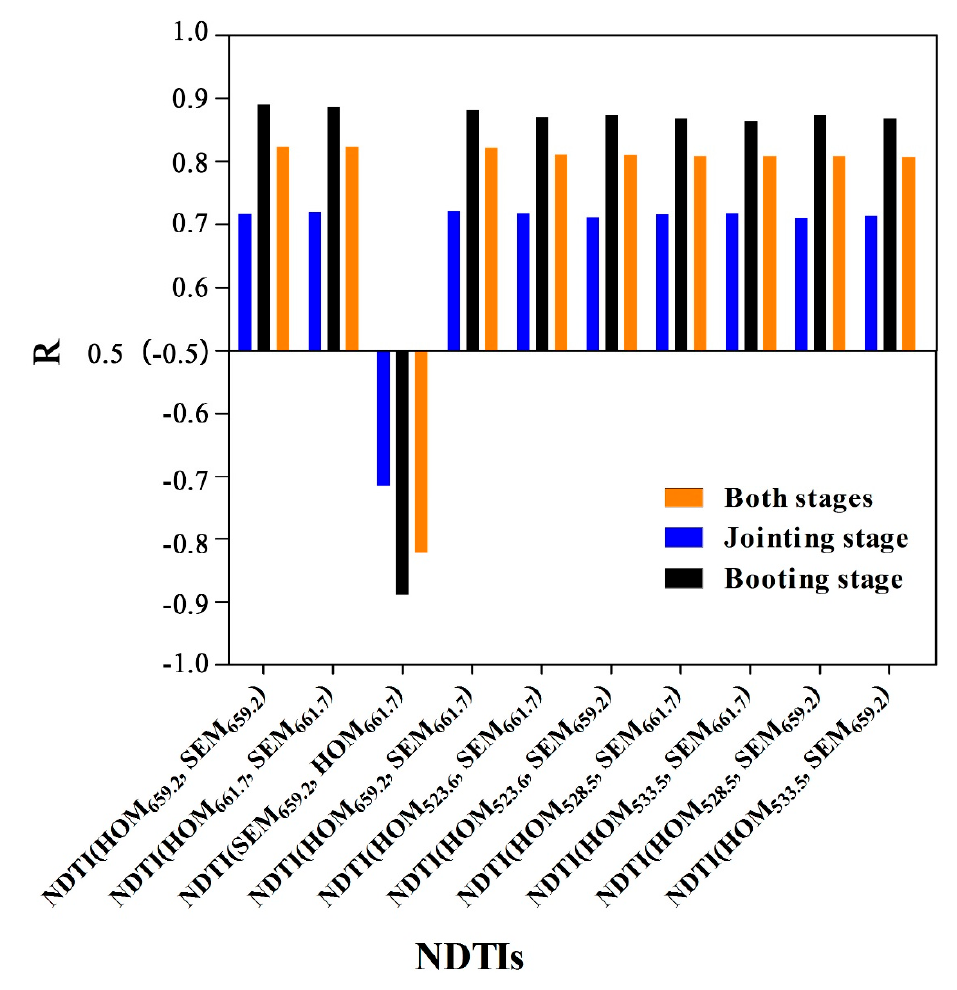
Figure 8. The correlation coefficient of the top 10 normalized difference texture indices (NDTI) which are highly correlated with DS.